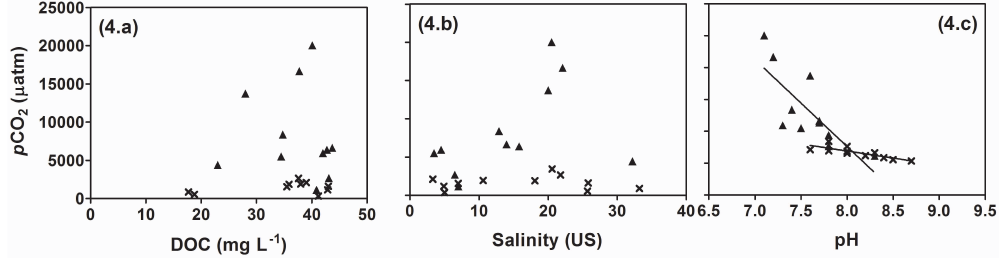
Fig. 4. The relationships of p CO 2 with (a) DOC, (b) salinity and (c) pH in 11 lakes sampled simultaneously within drier (crosses) and rainier (full triangles) sampling events. Only pH showed significant linear regressions ( p < 0 . 05) with p CO 2 in each period ( p CO 2 = − 2214pH + 19,620, R 2 = 0.61 for the drier one; p CO 2 = − 13,640pH + 111,800, R 2 = 0.66 for the rainier one), and combining both ( p CO 2 = − 9823pH + 82,090, R 2 = 0.60).